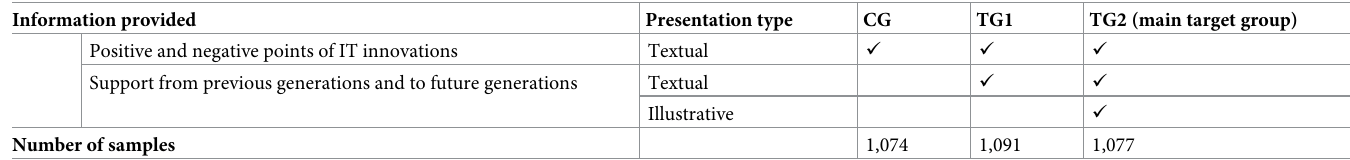
Table 1. Group definitions in the